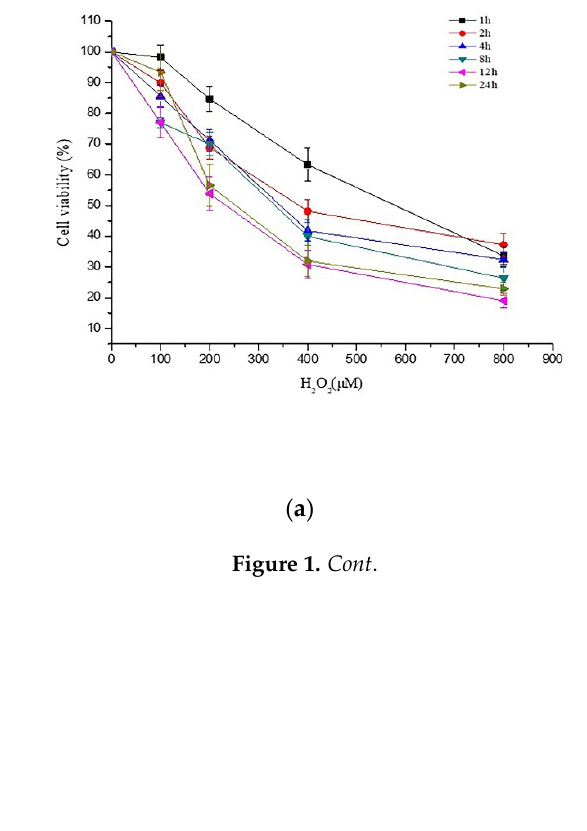
(Figure 1b). N-Acetyl-L-cysteine (NAC), which is known to protect against H 2 O 2 -induced oxidative damage, was used as a positive control.